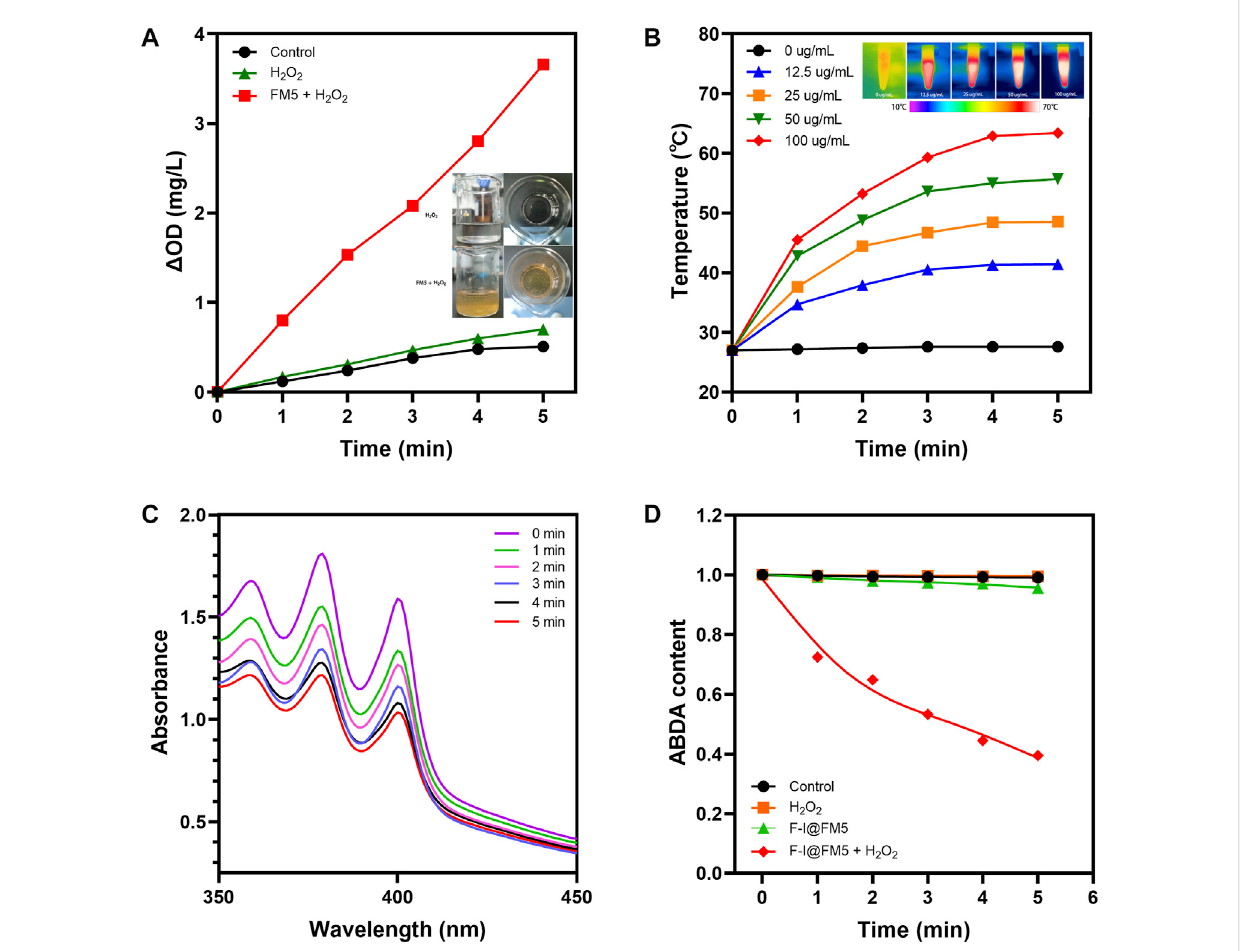
Physical and chemical properties F-I@FM5. (A) Time-dependent changes of dissolved O 2 concentrations in different groups. Insert map is Bubble generation in solutions. (B) Temperature changes of F-I@FM5 with different concentrations under NIR. Inset map is the infrared images of different groups after 5 min of illumination. (C) Absorption spectra of ABDA at different times in F-I@FM5 + H 2 O 2 group. (D) Changes of ABDA content in different